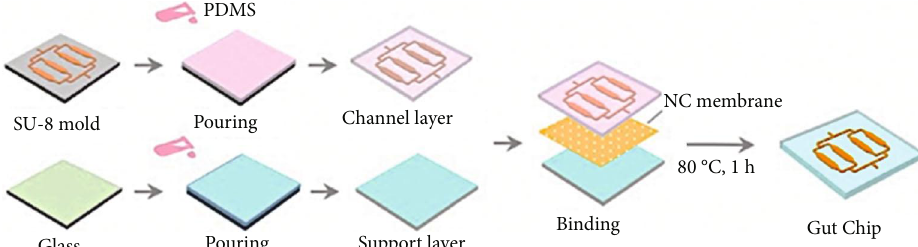
Figure 15: Fabrication process of the biomimetic human gut-on-a-chip. The channel layer and the support layer were made of PDMS, and the middle layer was fabricated of nitrocellulose. Reproduced (or adapted) with permission [93], ©2018, Wiley Online